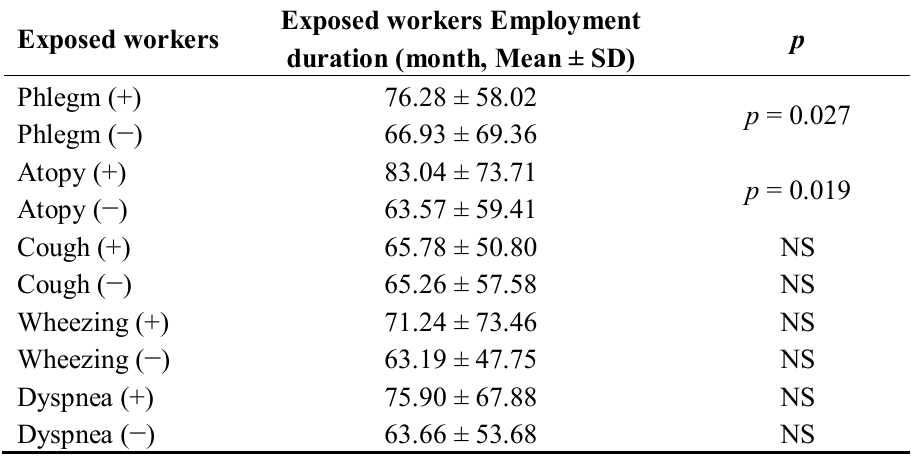
Table 3. Comparison of employment duration means by phlegm and atopy. Exposed